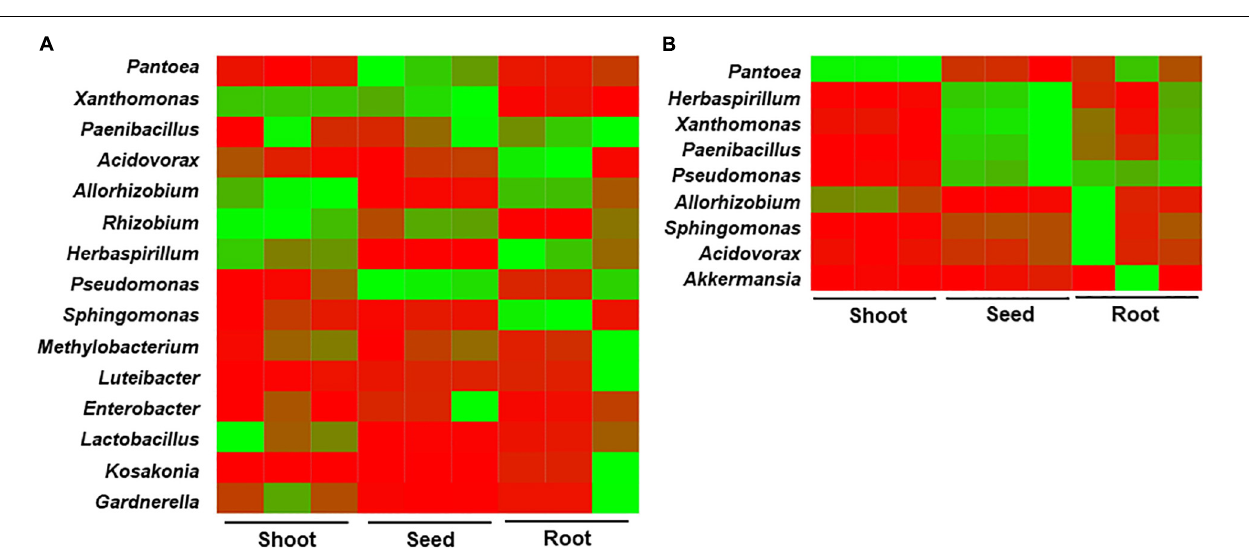
FIGURE 6 | Heat map analysis for the bacterial community structure in compartments of rice seedlings. The rice seeds were stored at (A) 4 ◦ C and (B) 15 ◦ C for 6 months, germinated and cultivated for 10 days. Bacterial compositions were compared between the roots, shoots, and seed